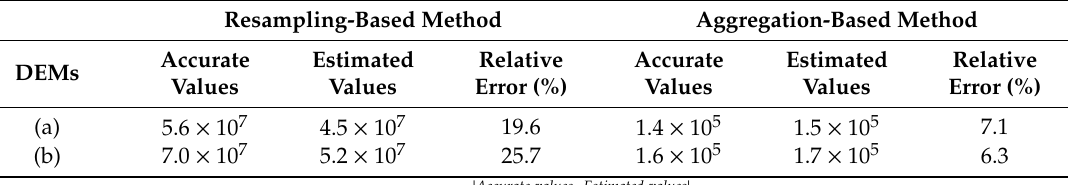
Figure 10. Two DEMs obtained from the Geospatial Data Cloud site (http://www.gscloud.cn). ( a ) One DEM with low heterogeneity; ( b ) Another DEM with low heterogeneity. Table 5. A comparison of absolute Boltzmann entropy computation by the resampling-based method and the aggregation-based method.